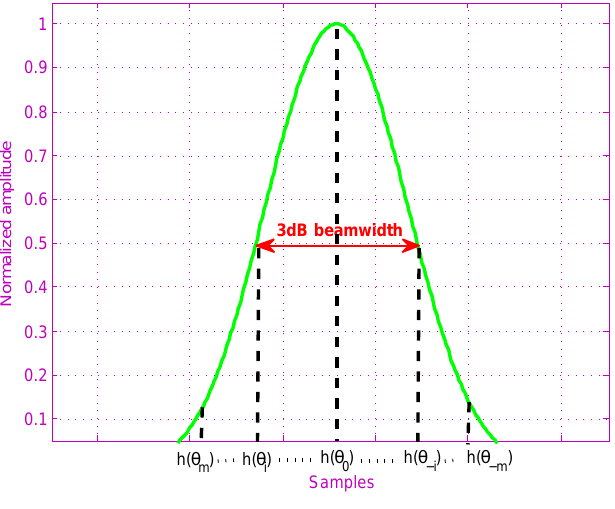
Figure 3. Antenna